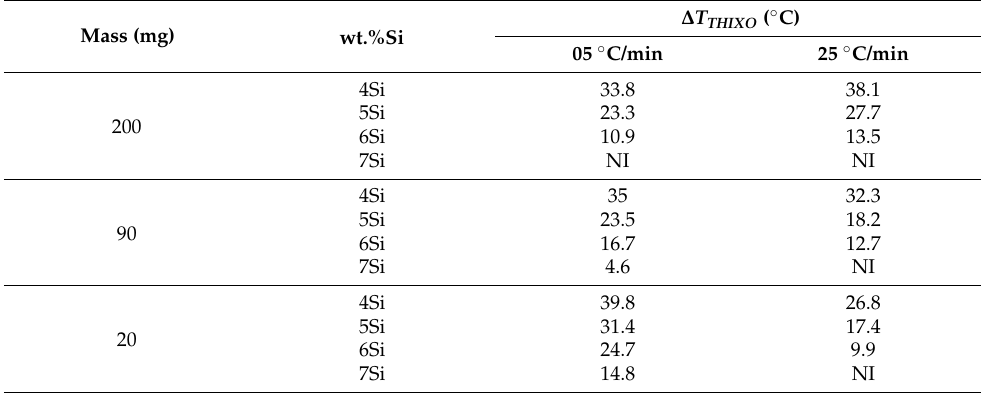
Figure 12. f S vs. T curve for 4, 5, 6 and 7 wt.%Si with heating rates of 5 and 25 ◦ C/min and sample masses of 200 ( a ) 90 ( b ) and 20 mg ( c ). Table 7. The ∆ T THIXO Al X Si 4 Zn for 05 ◦ C/min and 25 ◦ C/min, with a sample mass 200 mg, 90 mg, and 20